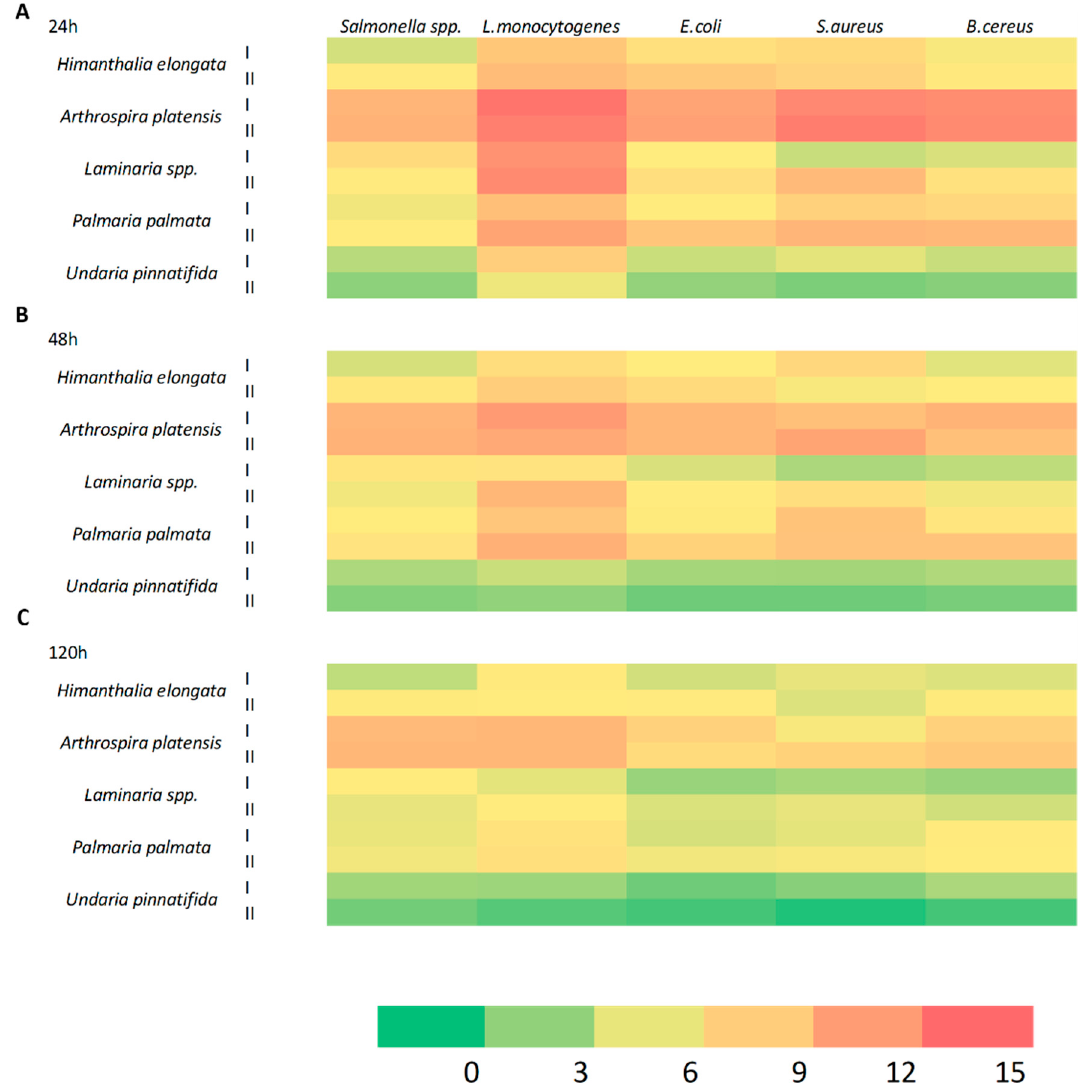
Figure 1. Antimicrobial activity of algae extracts towards Salmonella spp., L. monocytogenes , E. coli , S. aureus and B. cereus represented by heatmap. A scale ranging from a minimum of 0 mm (green) to a maximum of 15 mm (red) was used to represent size of inhibition diameter calculated, as average values of triplicates, after 24 h ( A ), 48 h ( B ), and 120 h ( C ) of incubation at 37 °C. I and II represent two different extracts referred to the same algae species.